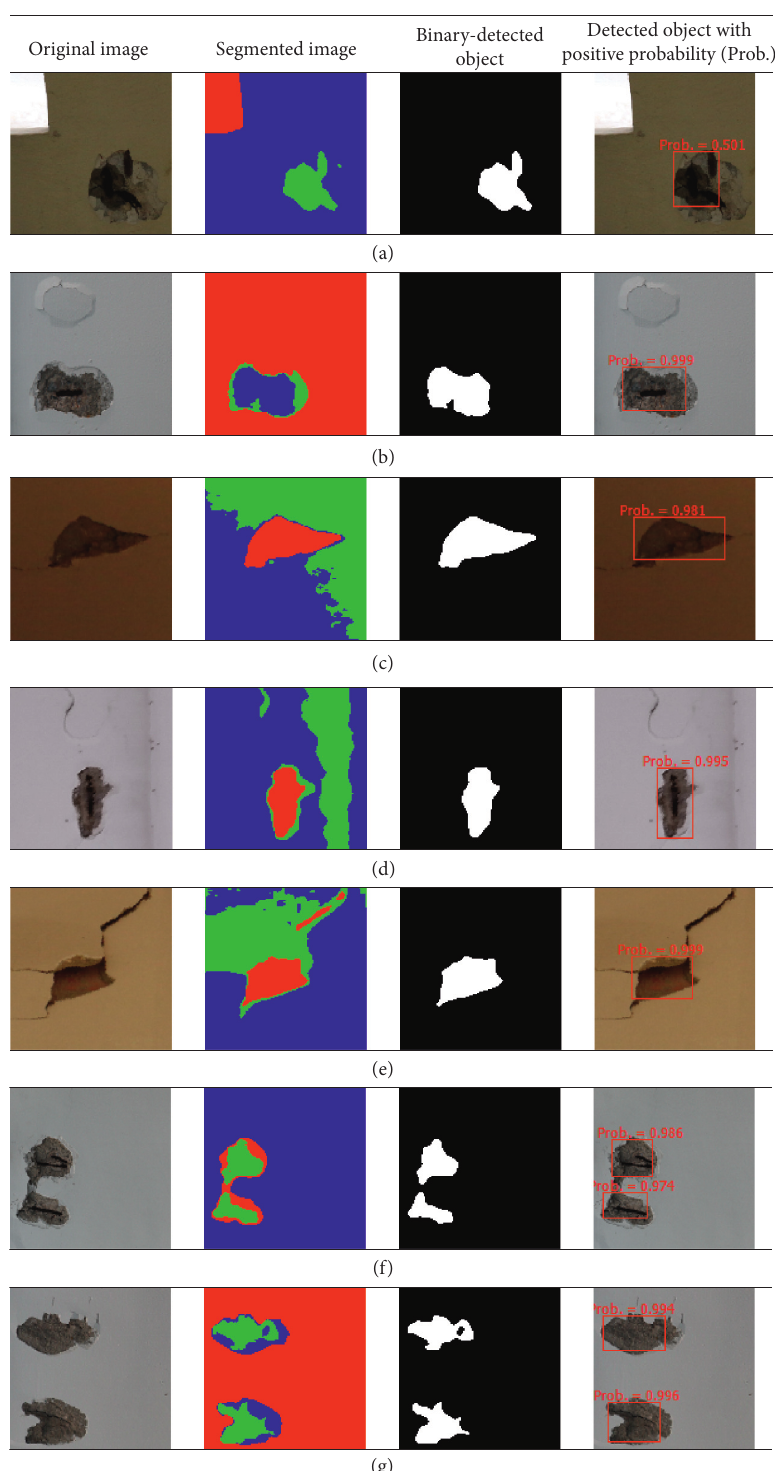
Figure 11: Illustrations of correctly classified